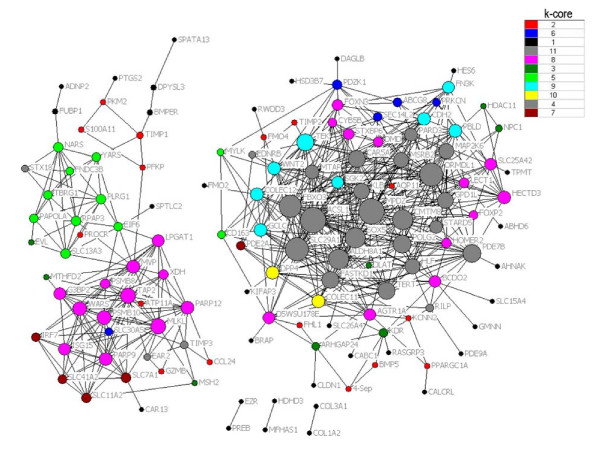
Gene co-expression network. Genes from profiles No.9 and No.16 were analyzed and identified by gene co-expression network with k-core algorithm. Cycle nodes represent genes, the size of nodes represents the power of the interrelation among the nodes, and edges between two nodes represent interactions between genes. The more edges of a gene, the more genes connecting to it, the more central role it has within the network.